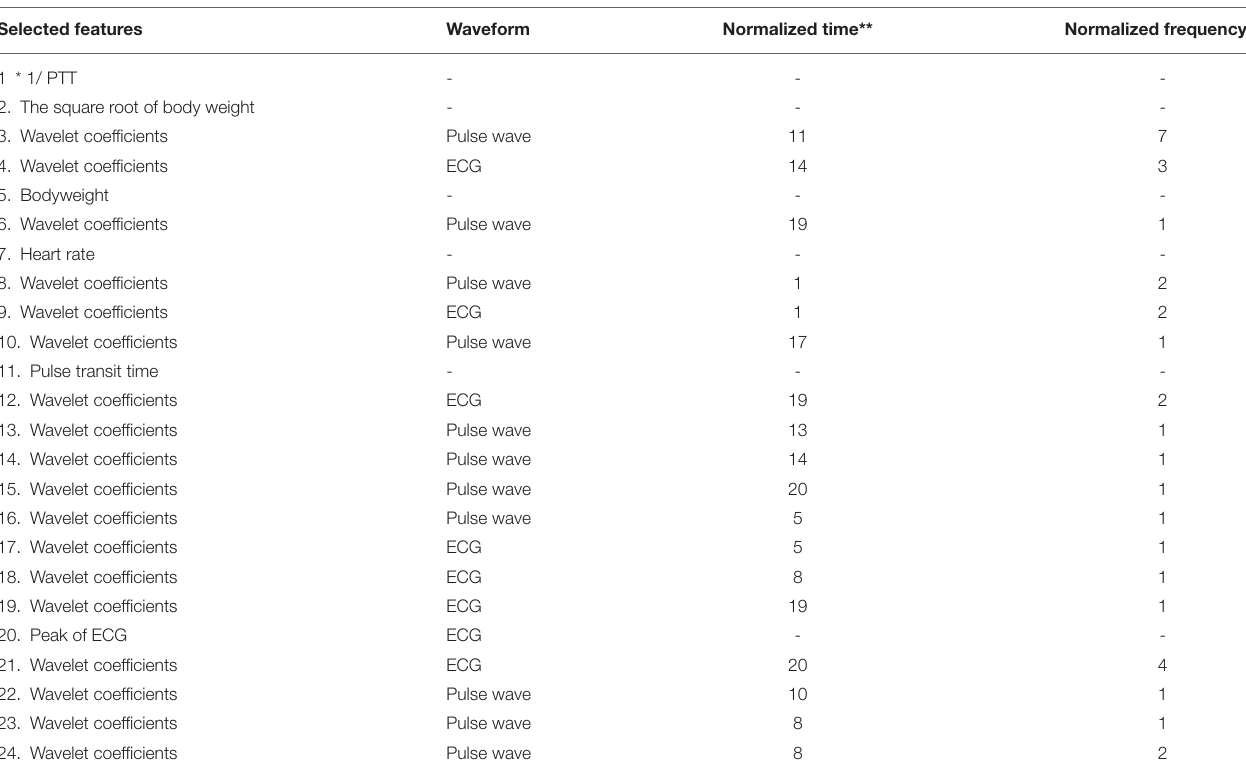
TABLE 4 | Selected feature values. Selected features